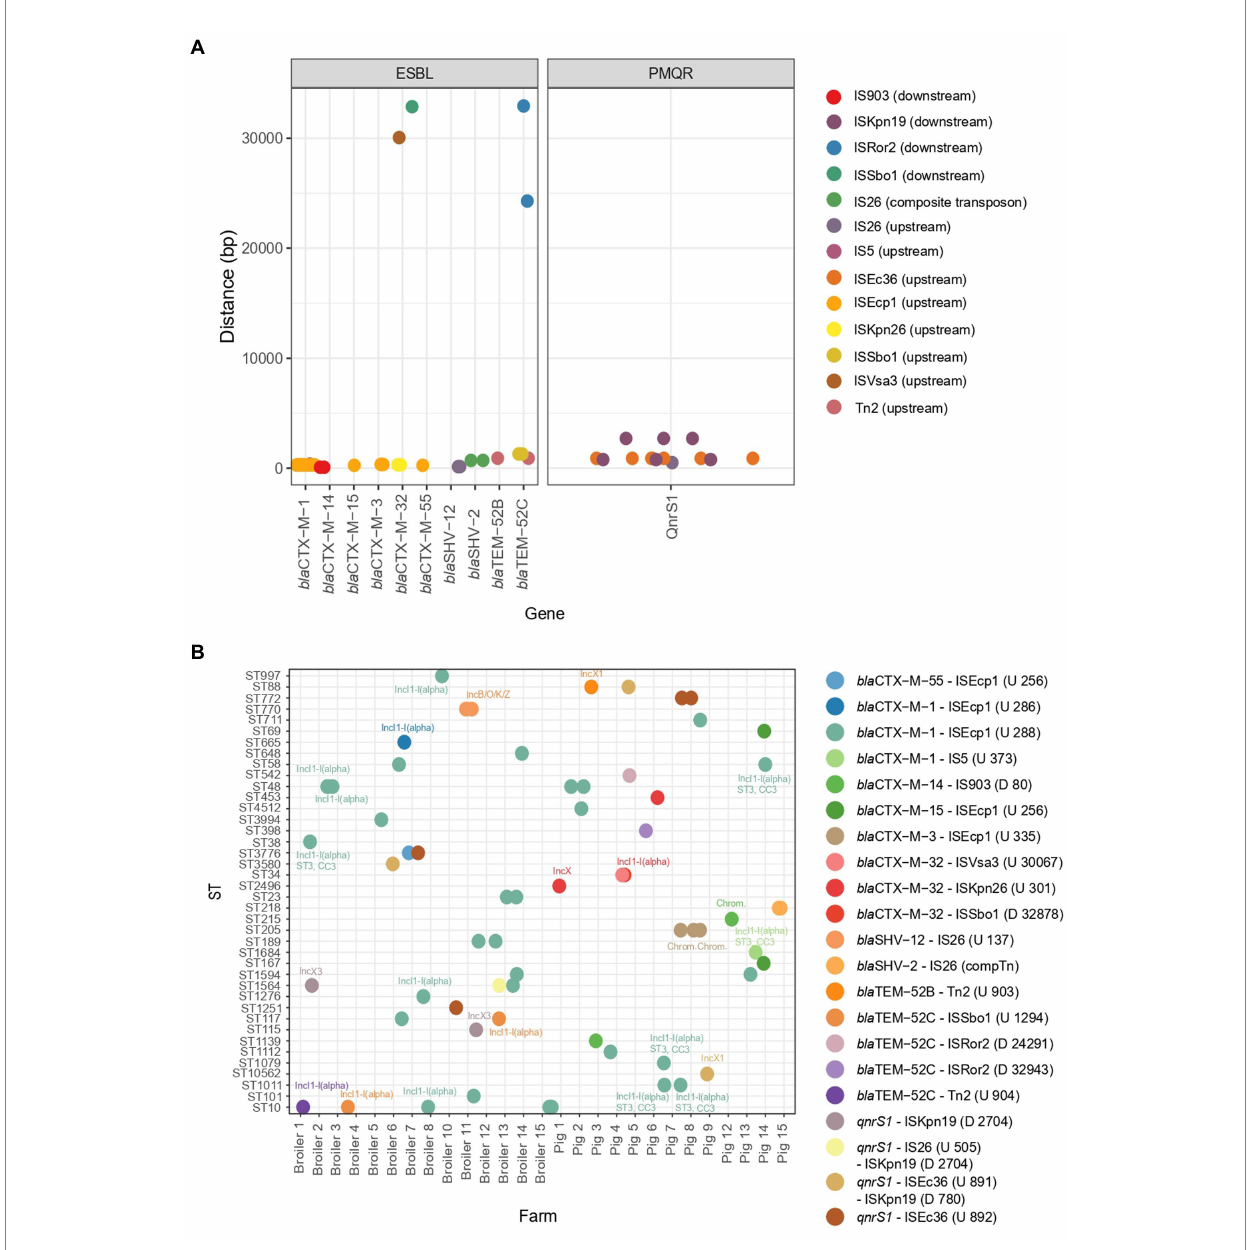
FIGURE 5 Mobile genetic elements and their association to ESBL genes and PMQR genes. (A) Distance of mobile genetic elements to the ESBL or PMQR gene. (B) The combination of the ESBL/PMQR gene with the closest mobile genetic element for every farm and ST element. The plasmid origins of replication are indicated in the figure. The distance and upstream (U)/downstream (D) location of the mobile genetic element are indicated in the figure